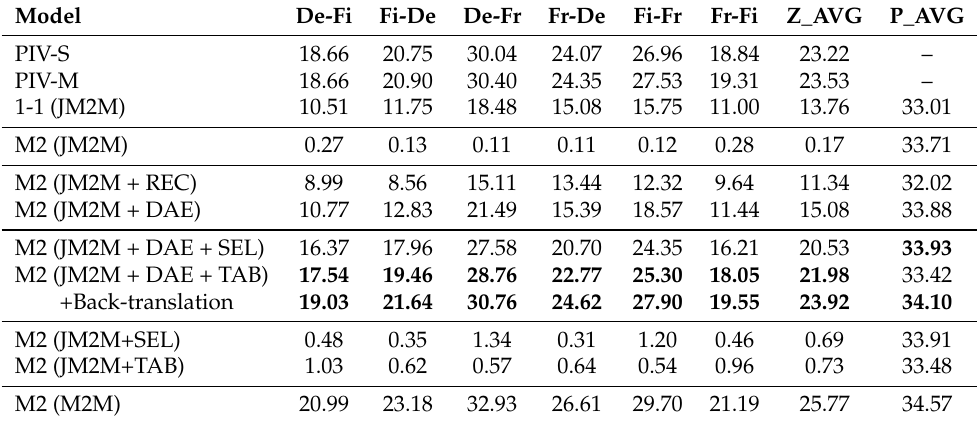
Table 3. Zero-shot translation results. For all M2 models except M2 (M2M), a fully supervised “upper bound”, the top two scores in each column are highlighted in bold. REC represents reconstruction task, SEL represents sharing top encoder layers as an NIM, TAB represents the Transformer attention bridge as an NIM. P-AVG and Z-AVG represent average scores of parallel translation and zero-shot translation,